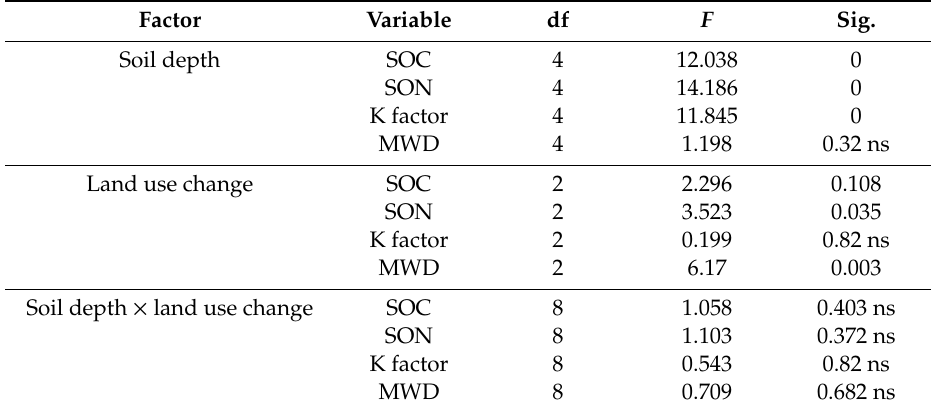
Table 3. E ff ects of soil depth, land use change, and their interactions on soil organic carbon (SOC) content, soil organic nitrogen (SON) content, K factor, and